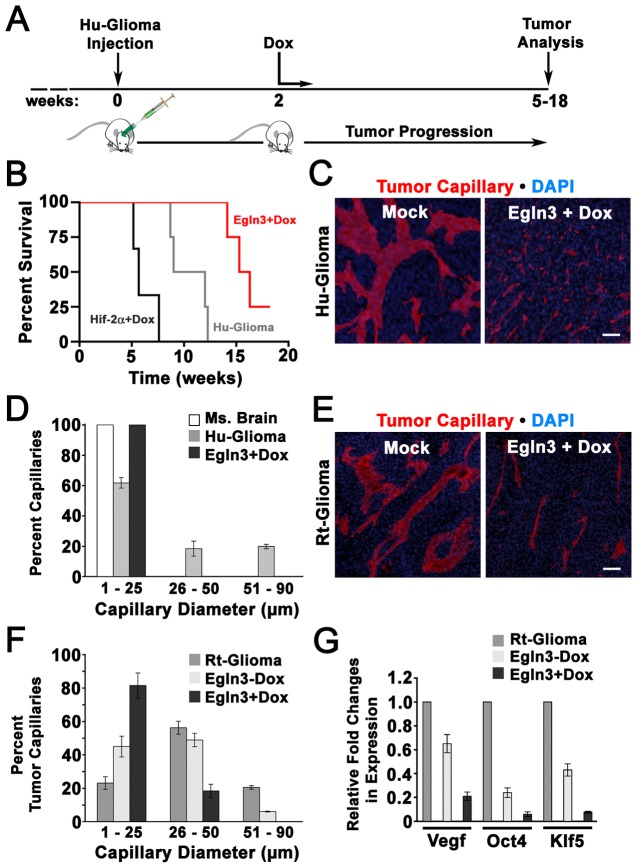
Expression of Egln3 decreases tumor aggression, increases survival and normalizes glioma vascular architecture.(A) Timeline for the intracranial xenoengraftment of Hu-glioma initiating cells, Dox-induced expression of Egln3 in tumor cells and tumor analysis. (B) Kaplan-Meier survival curves for Hu-glioma (empty vector transfected; grey), Hu-glioma Egln3 + Dox (red), and Hu-glioma Hif-2αP531A + Dox as a control (black); in total, n = 18). (C) Fluorescent images of intra-tumor blood capillaries. Gliomas originating from Hu-glioma initiating cells (empty vector transfected) and Hu-glioma Egln3 + Dox cells were allowed to develop until the onset of neurological symptoms and labeled with anti-CD31 (PECAM) antibodies and DAPI. Scale Bar  = 100µm. (D) Percentage of CD31-labeled blood capillaries that exhibited diameters of 1–25µm, 26–50µm or 51–90µm relative to internal scale bars in non-cancerous adult mouse brain, Hu-gliomas (empty vector transfected) and Hu-gliomas Egln3 + Dox after tumor progression elicited neurological symptoms. >500 capillaries of 10 randomly chosen tumor sections were chosen from 3 glioma engrafted mice for each experimental group. Mean values +/− s.d. are shown; n = 4. (E) Rt-glioma (empty vector transfected) and Rt-glioma Egln3 + Dox were allowed to develop until the onset of neurological symptoms and fluorescently labeled with the endothelial-specific probe, isolectin GS-IB4 (Lectin) and DAPI. Scale Bar  = 100µm. (F) Percentage of Lectin-labeled tumor blood capillaries that exhibited diameters of 1–25µm, 26–50µm or 51–90µm in empty vector transfected Rt-gliomas and Rt-gliomas Egln3 +/− Dox after tumor progression elicited neurological symptoms. Mean values +/− s.d. are shown; n = 4. (G) Empty vector transfected Rt-glioma and Rt-glioma Egln3 +/− Dox tumors were allowed to progress until neurological symptoms were noted. Quantification of Vegf, Oct4 and Klf5 mRNA expression in total tumor were determined by RT-QPCR. Data are expressed as fold changes relative to empty vector transfected Rt-glioma tumor samples. Mean values +/− s.d. are shown.